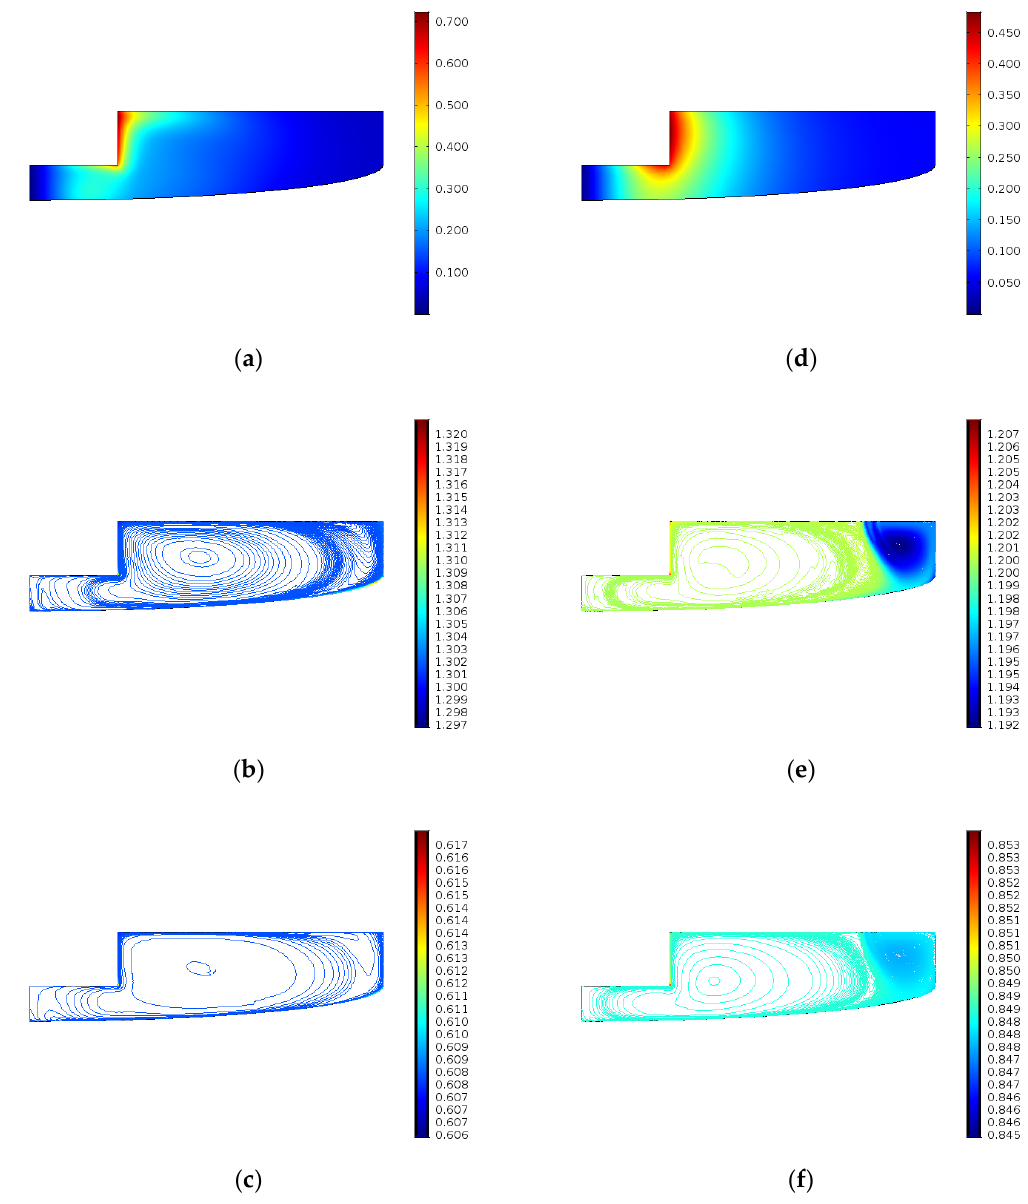
Figure 7. Results after 4 h ( a ) velocity field (m / s) in case of experiment 8; ( b ) ECSO concentration (mol / m 3 ) in case of experiment 8; ( c ) CO 2 concentration (mol / m 3 ) in case of experiment 8; ( d ) velocity field (m / s) in case of experiment 12; ( e ) ECSO concentration (mol / m 3 ) in case of experiment 12; ( f ) CO 2 concentration (mol / m 3 ) in case of experiment 12.